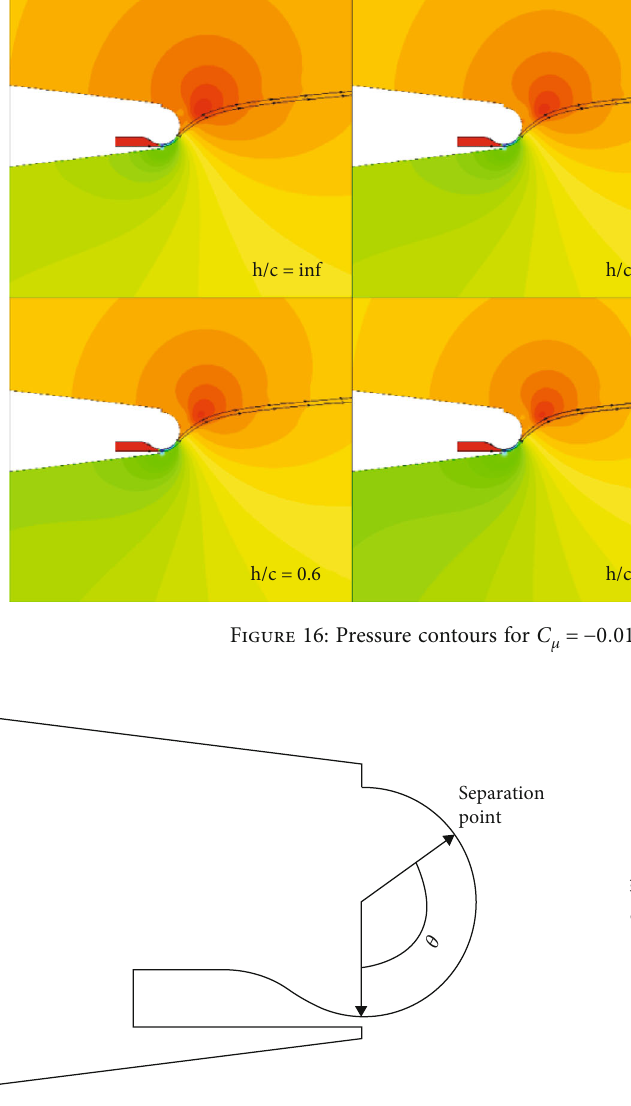
Figure 17: De fi nition of separation angle for the case with lower slot blowing.